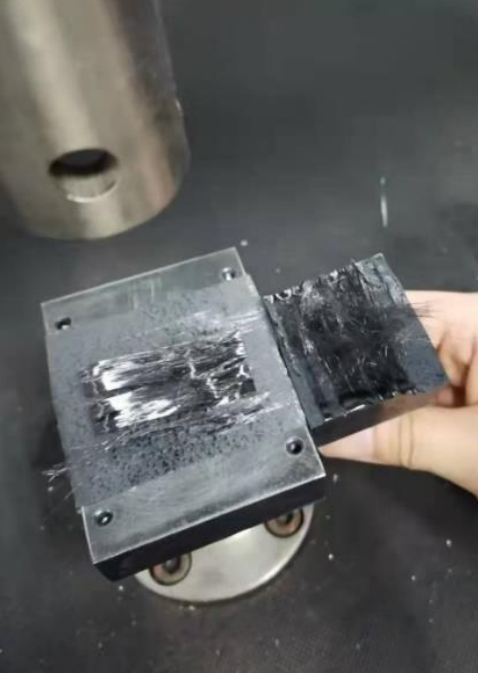
Figure 12. Delamination damage of prepreg in the low-speed experiment. According to the experimental conditions listed in Section 4.2.1, five experiments are carried out for each experimental condition, and the average value is taken. Figure 13 shows the obtained laying speed/allowable normal stress curve: